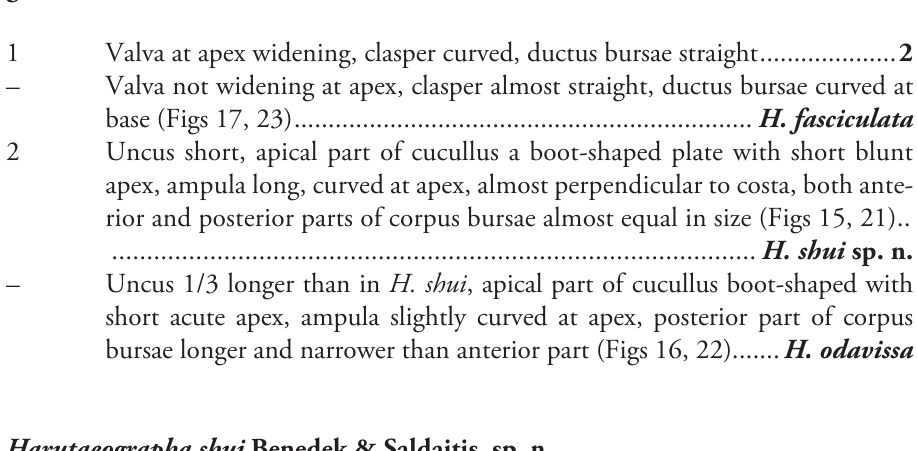
Type material. Holotype : male (Fig. 6), China, Sichuan, 29°43.105'N, 02°36.195'E,